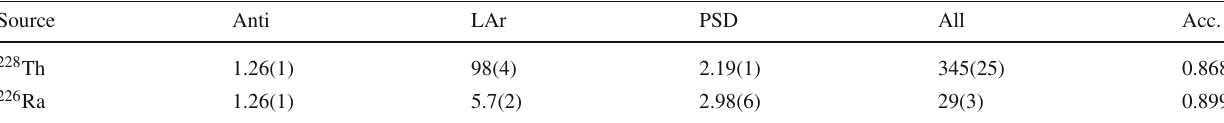
Table 12 Suppression factors obtained in the ROI with a 228 Th and 226 Ra source from Ge anti-coincidences (anti), the LAr veto (LAr), pulse shape discrimination (PSD), and after all cuts (all); the acceptance (acc.) values refer to all cuts